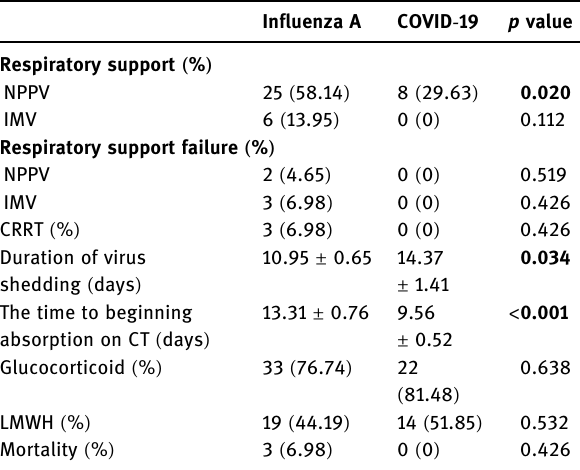
Table 3: Treatment and prognosis of two groups In fl uenza A COVID - 19 p